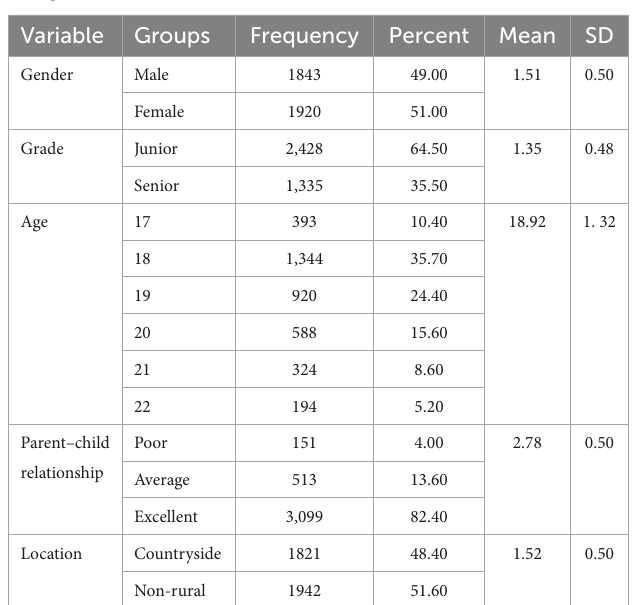
TABLE 1 Descriptive of general demographic characteristics of returned college students ( n =